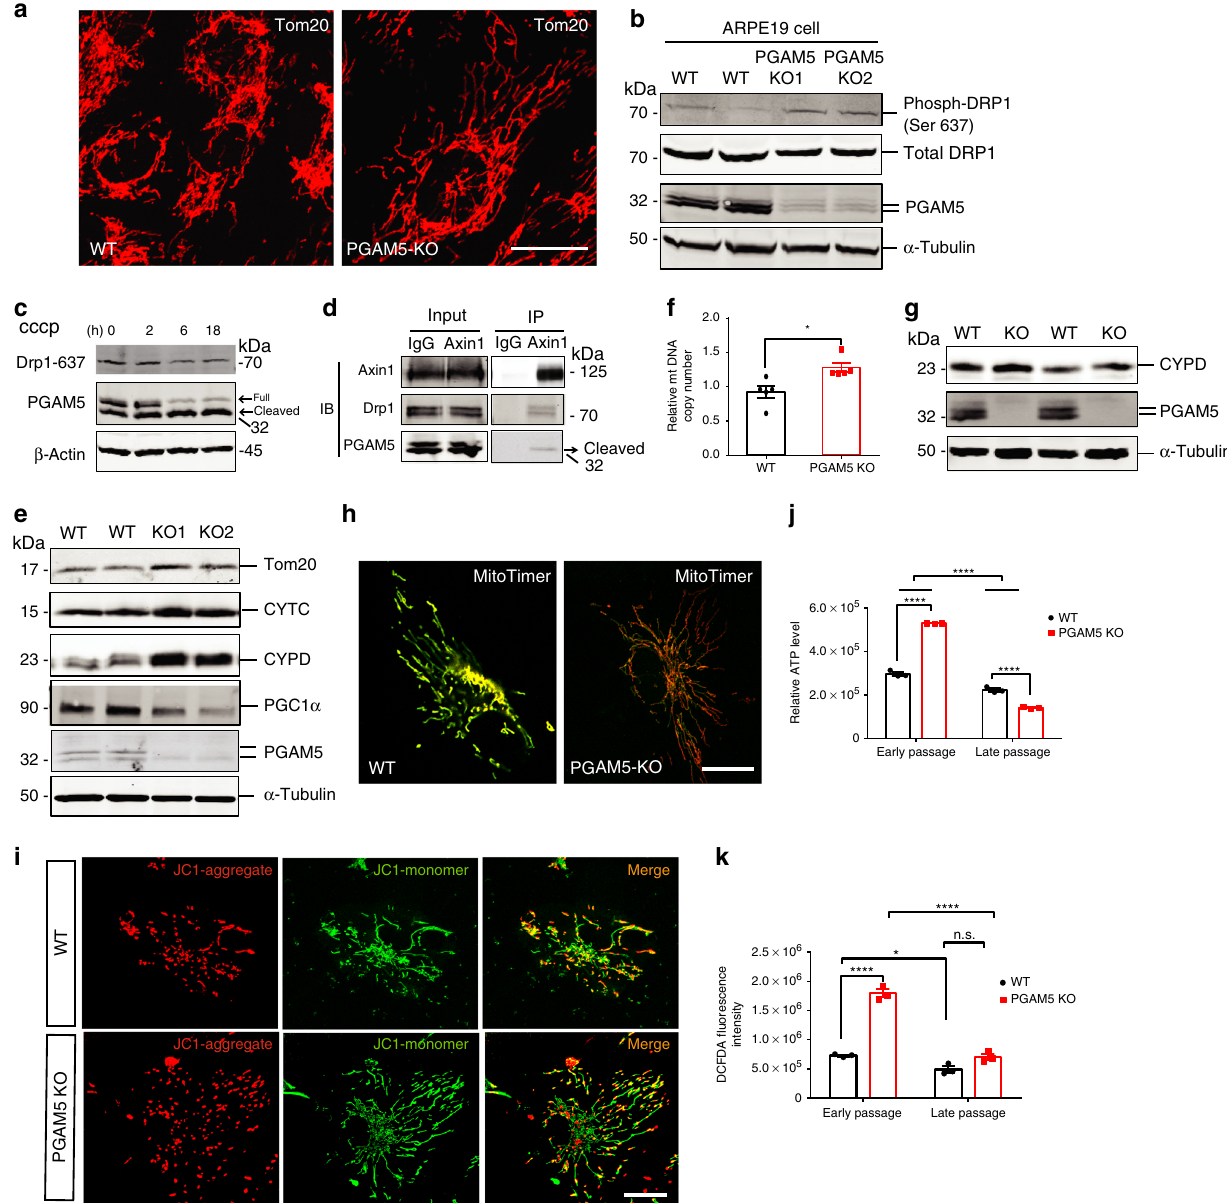
Fig. 3 Mitochondrial dynamics and function change upon PGAM5 deletion. a Mitochondrial morphology outlined by Tom20 antibodies in control